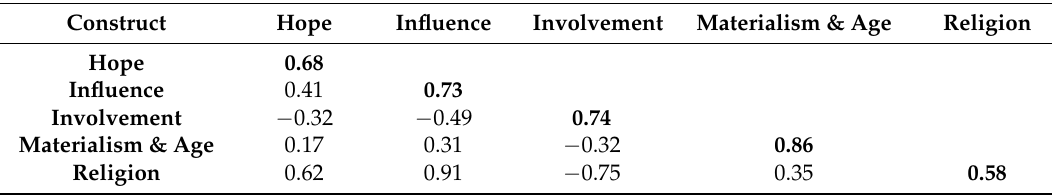
Table 4. Discriminant